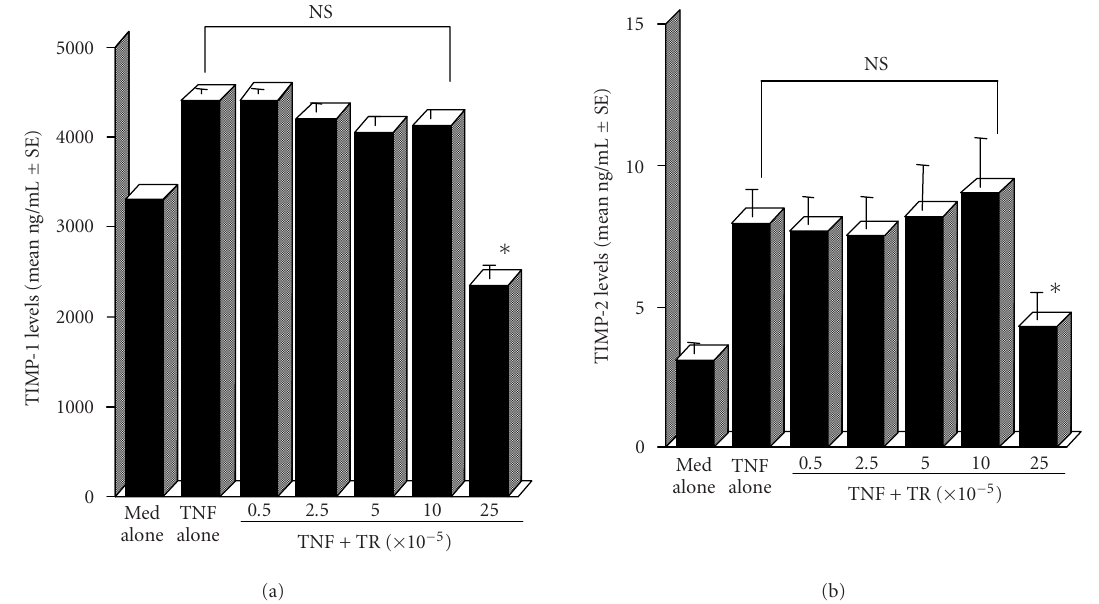
Figure 3. Influence of tranilast (TR) on the production of TIMP-1 and TIMP-2 from nasal fibroblasts in response to TNF- α stimu- lation. Cells were stimulated with 10.0 ng/mL TNF in the presence of various concentrations of TR for 24 hours. Data are expressed as the mean ng/mL ± SE of five di ff erent subjects. NS means not significant ( P > . 05); ∗ means significant ( P < . 05) compared with TNF